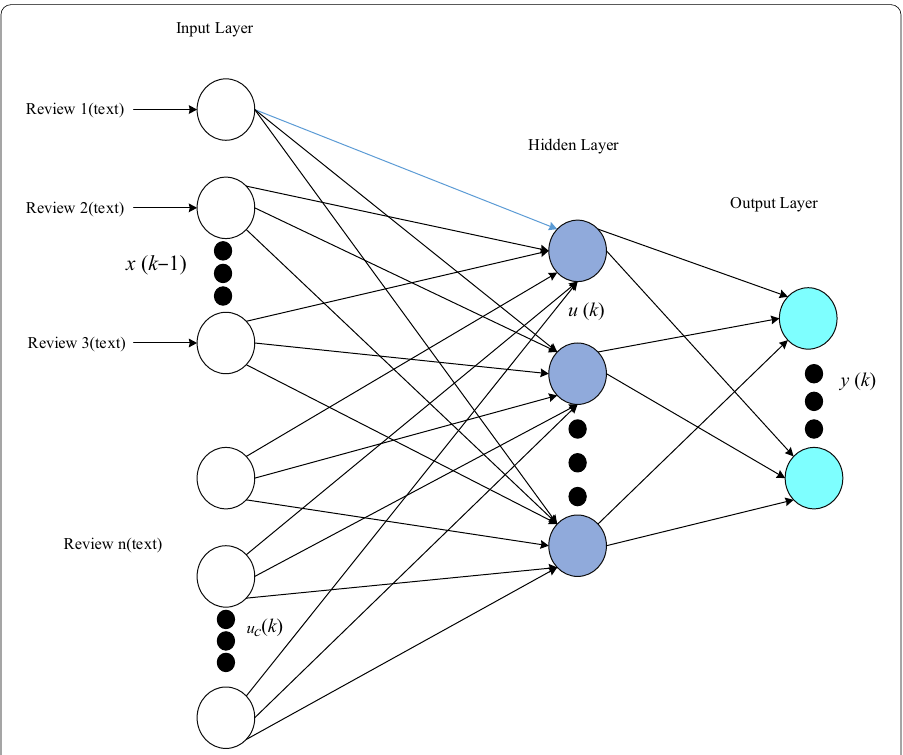
Fig. 2 Recurrent neural network architecture of venue recommendation based on user tags and